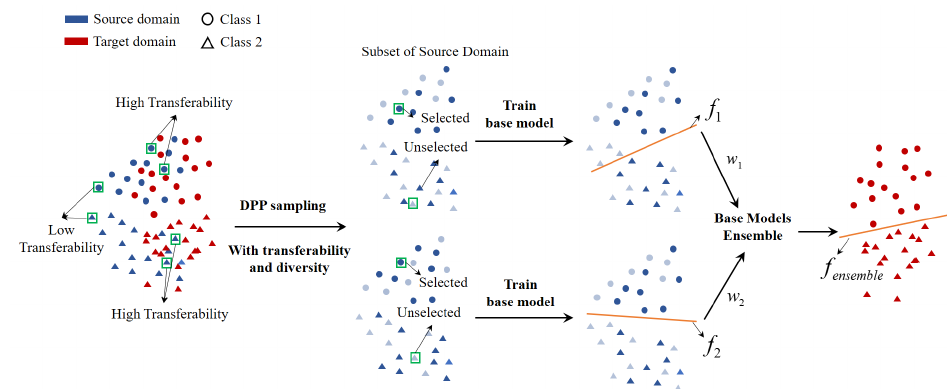
Figure 1. Ensemble strategybBased on DPP sampling for transfer